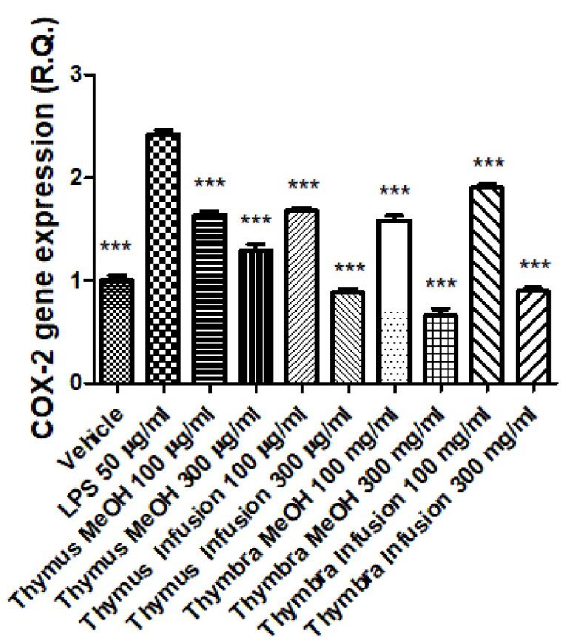
Figure 3. Inhibitory effects of Thymus sipyleus and Thymbra capitata extracts (100 – 300 µg/mL) on LPS-induced COX-2 gene expression, in isolated colon (ANOVA, p < 0.0001; *** p < 0.001 vs. LPS).